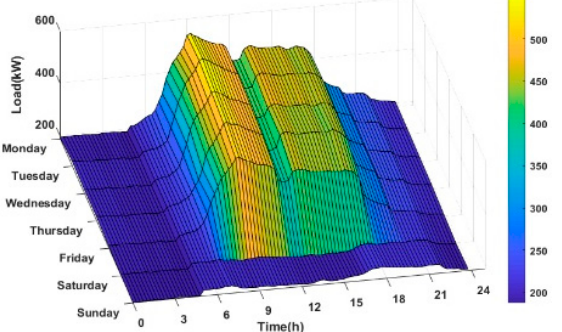
Figure 14. Korean research institute (KEPRI) demand load profile.